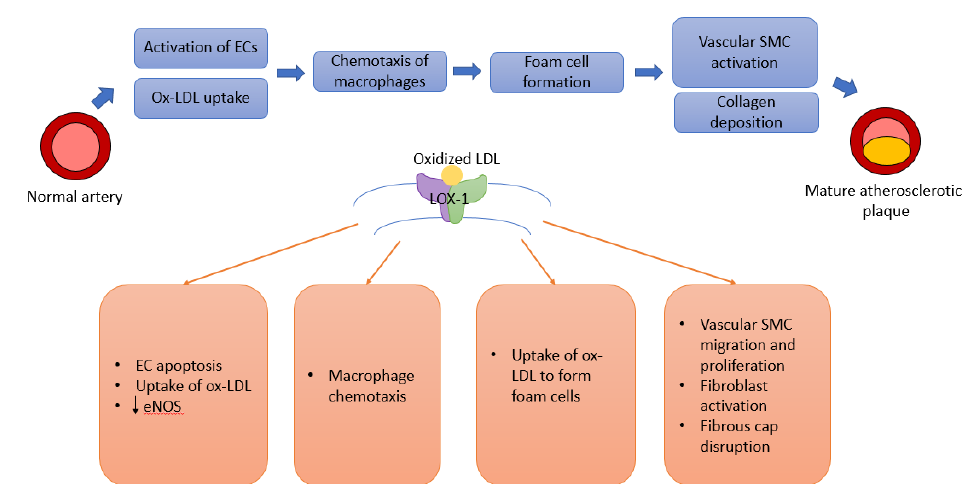
Figure 1: Pathway leading to atherosclerosis and the role of LOX-1. Abbreviations: EC: Endothelial cell; eNOS: endothelial nitric oxide synthase; LOX-1: Lectin-type oxidized LDL receptor-1; ox-LDL: Oxidized- Low density lipoprotein; SMC: Smooth muscle